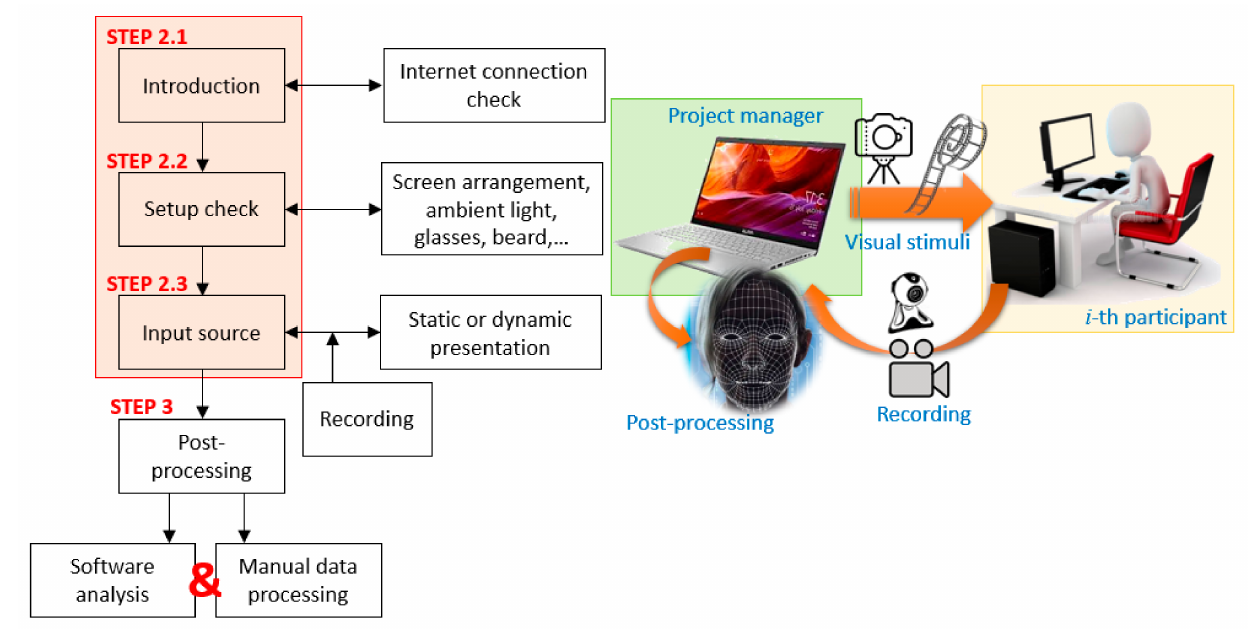
Figure 5. General procedure for the virtual experimental investigation (STEP